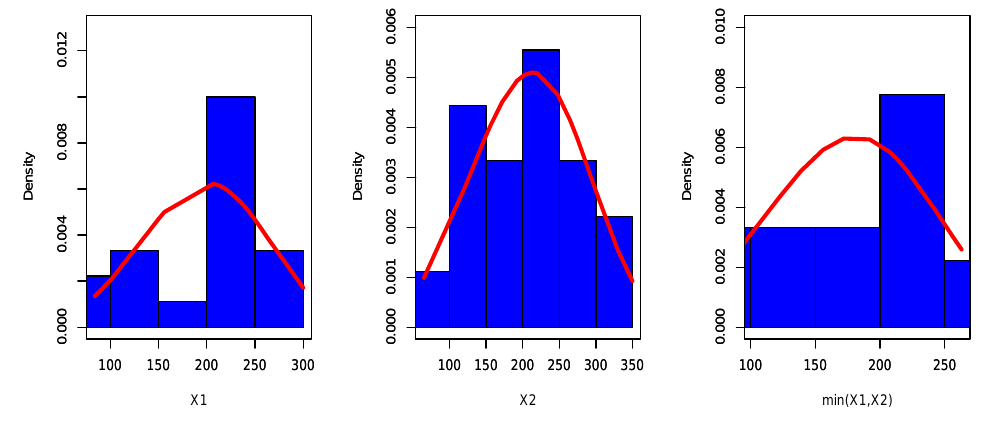
Figure 9. The fitted PDF for X 1 , X 2 and min ( X 1 , X 2 ) for data set II.